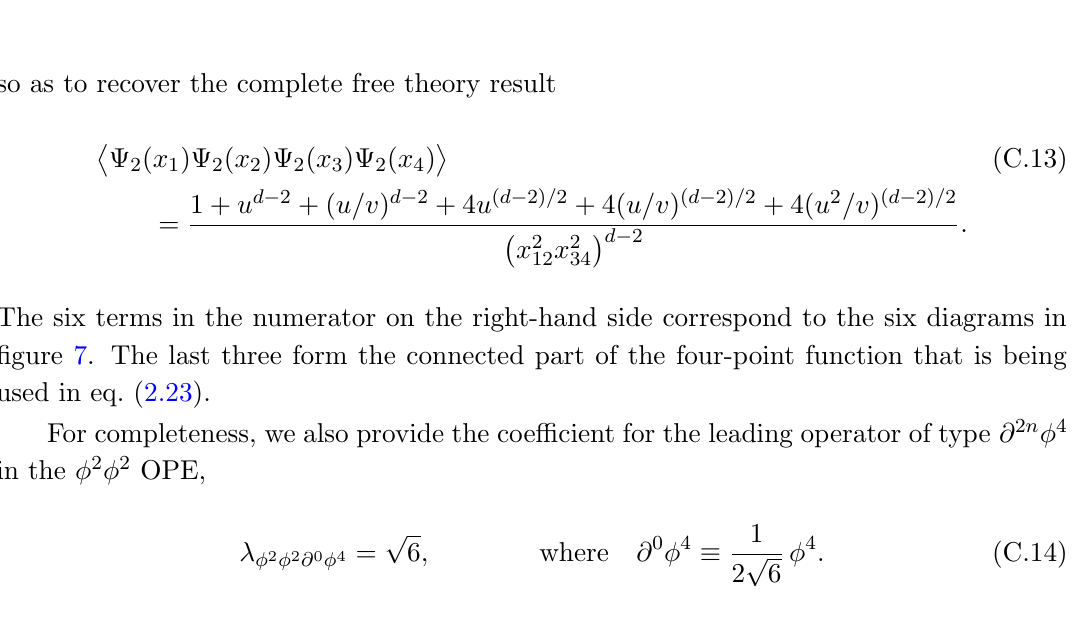
Figure 7 . The 6 Feynman diagrams that contribute to the four-point function for the operator (cid:30) 2 . (a), (b) and (c) are disconnected, (d), (e) and (f) are connected. In terms of an OPE grouping the two points to the left and the points to the right, (a) corresponds to the exchange of the identity operator (no (cid:30) ), (d) and (e) to operators of type @ 2 n (cid:30) 2 , (b), (c) and (f) to operators of type @ 2 n (cid:30) 4